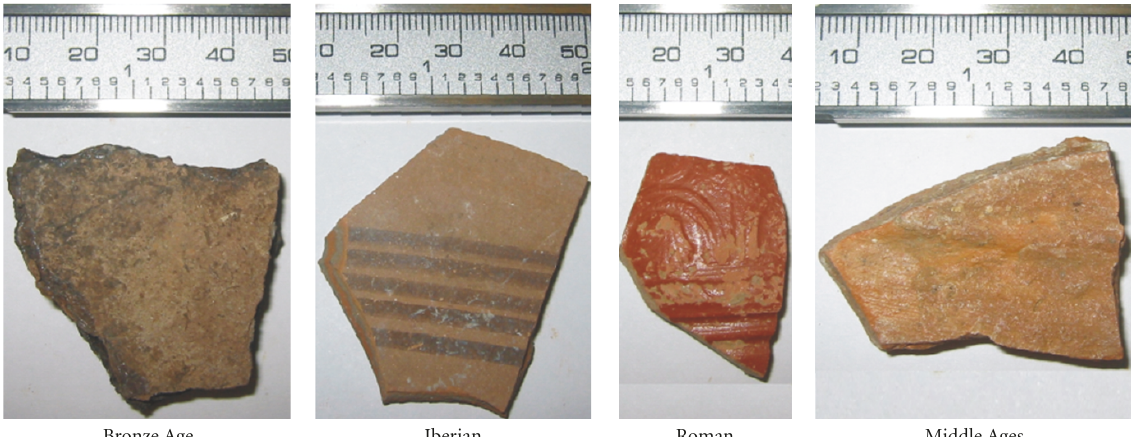
Figure 2: Images of typical ceramic pieces.